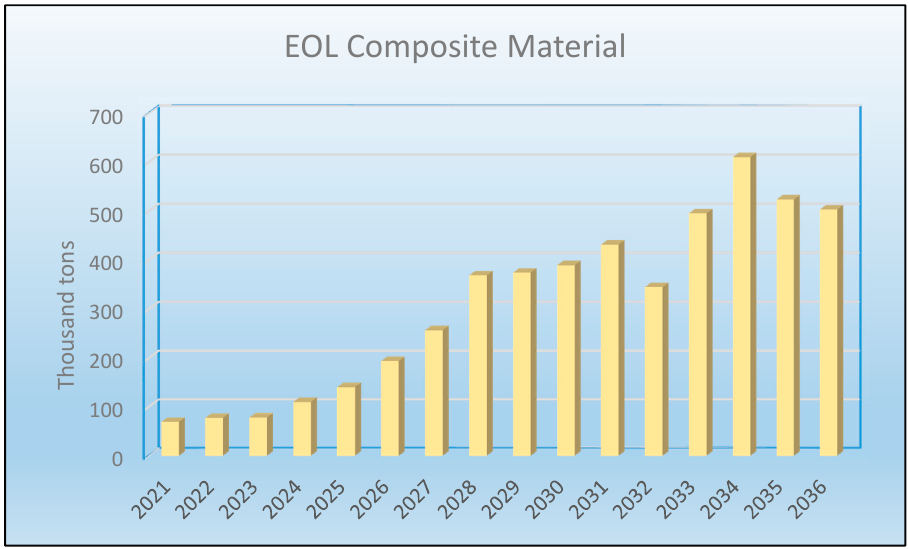
Figure 3. Expected volumes of composite material waste from the wind energy industry until the year 2036 (Data source [8,16,21,29]).